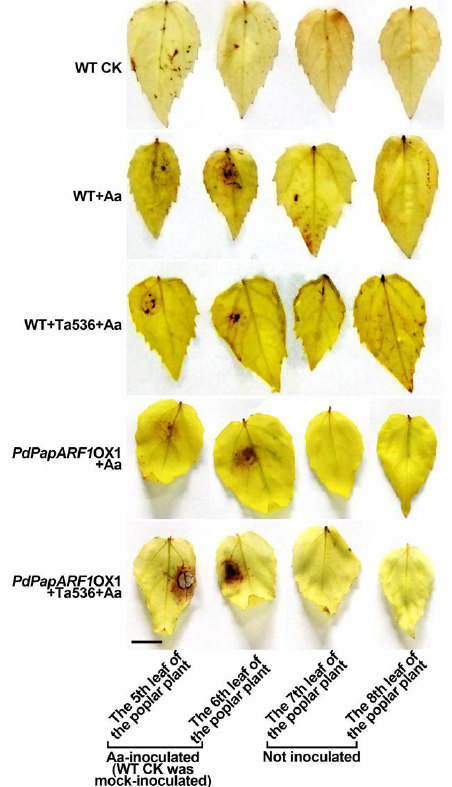
Figure 3. The 3,3′-diaminobenzidine (DAB) staining results of the leaves of three-week-old poplar clones subcultured under sterile conditions. Bar = 1 cm. Please note that all the inoculated leaves were punctured once, including in mock-inoculation. See details in the material and methods section.